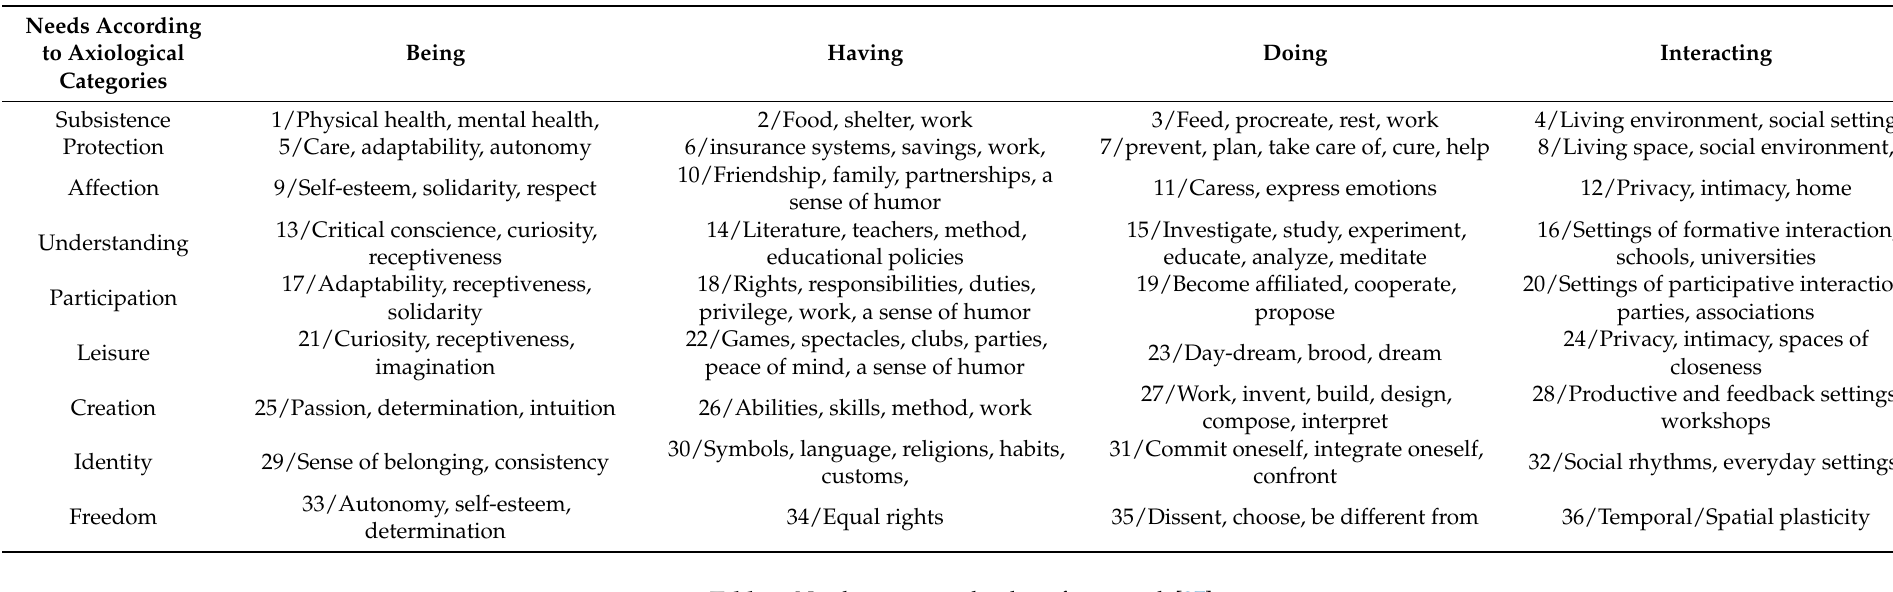
Table 5. Human needs matrix [38].